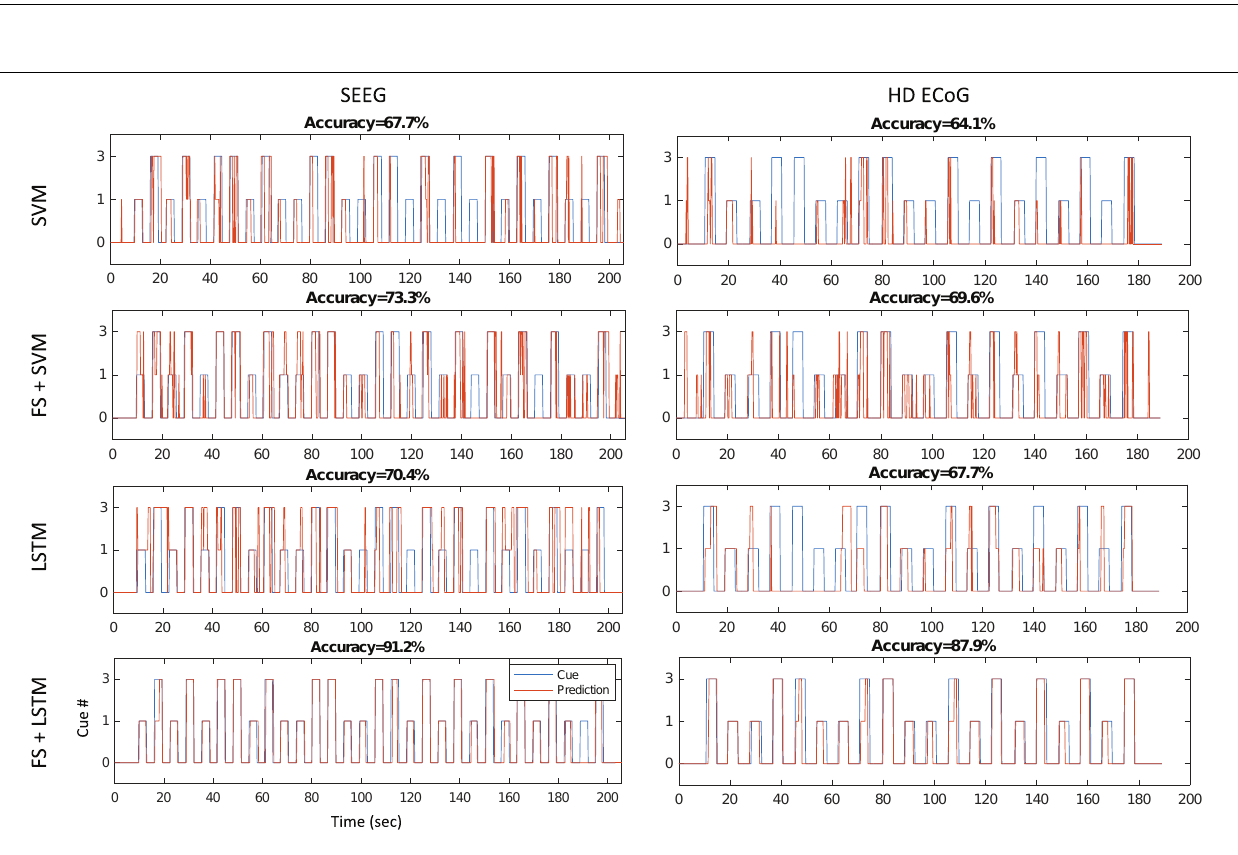
FIGURE 6 | Decoding accuracies for different architectures during thumb and middle finger flexion task. Independent test sets results are shown for four different decoding architectures tested offline with SEEG and ECoG recordings in participant P3: the first row results are for a multi-class non-linear SVM using a gaussian kernel without feature selection, the second row are results for an architecture that performs repeatability-based feature selection (MCC > 0.6) and SVM, the third row shows results for a LSTM recurrent neural network without feature selection, and the last row shows results for an architecture using feature selection as described and a LSTM recurrent neural